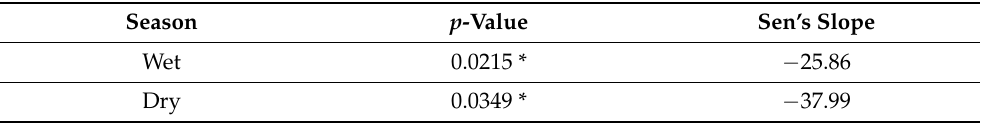
Table 1. The evolutionary trend of inundation in the study area for the wet season and dry season from 2002 to 2021. Season p -Value Sen’s Slope Wet 0.0215 * − 25.86 Dry 0.0349 * −